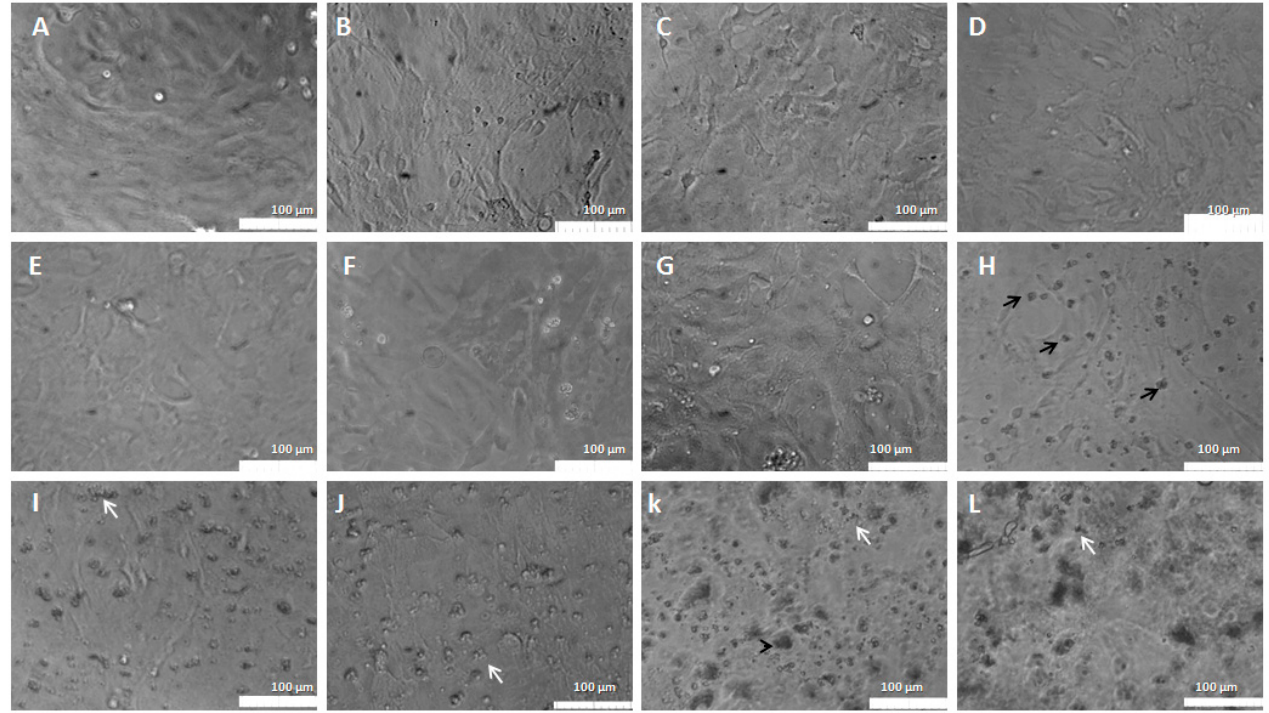
Figure 9. Morphological aspects of astrocytes treated with CP in conventional liposomes (0.2–30 μ g/mL). ( A )—Control: Astrocytes in DMEM medium. ( B )—Astrocytes in DMEM medium with 0.5% empty liposomes. ( C )—Astrocytes in DMEM medium with 0.2 μ g/mL. ( D )—Astrocytes in DMEM medium with 0.3 μ g/mL. ( E )—Astrocytes in DMEM medium with 0.6 μ g/mL. ( F )—Astrocytes in DMEM medium treated with 1 μ g/mL. ( G )—Astrocytes in DMEM medium with 2 μ g/mL. ( H )—Astrocytes in DMEM medium with 3 μ g/mL. ( I )—Astrocytes in DMEM medium with 6 μ g/mL. ( J )—Astrocytes in DMEM medium with 10 μ g/mL. ( K )—Astrocytes in DMEM medium with 20 μ g/mL. ( L )—Astrocytes in DMEM medium with 30 μ g/mL. The black arrows represent cells in the carotid cortex and the white arrows represent cell fragments.